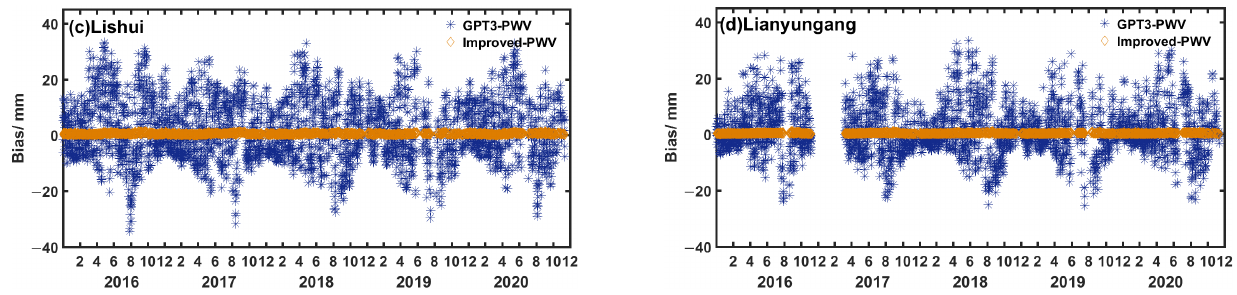
Figure 9. The bias of GPT3-PWV and improved-PWV in Anqing ( a ), Bengbu ( b ), Lishui ( c ), and Lianyungang ( d ) during the 2016–2020 period.